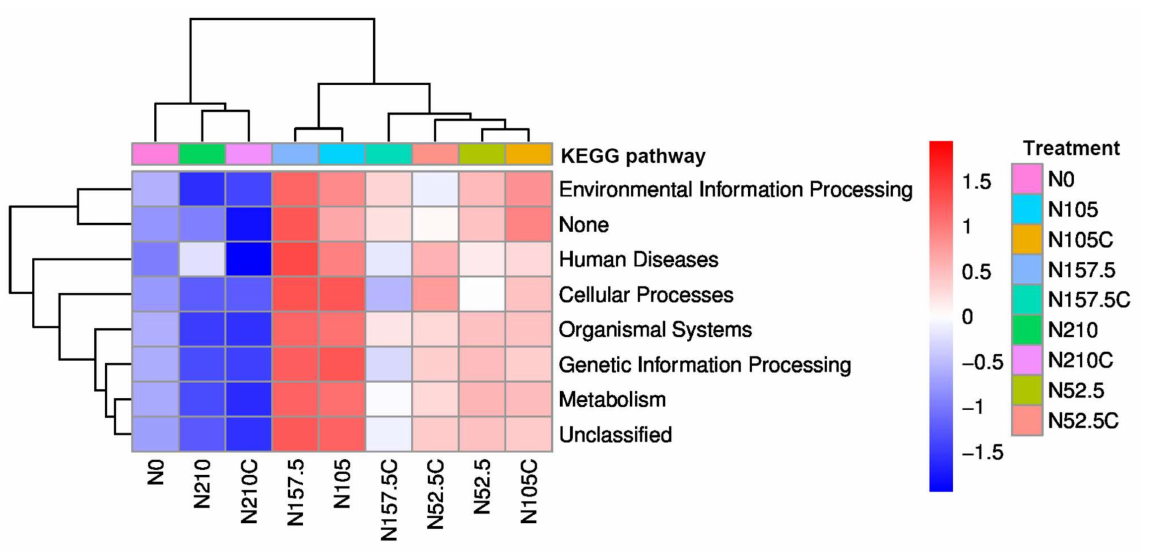
Figure 3. Clusters showing the relative abundance of soil bacterial communities predicted functions related to KEGG pathways the first level as affected by N fertilization. N0, 0 kg N ha − 1 year − 1 ;